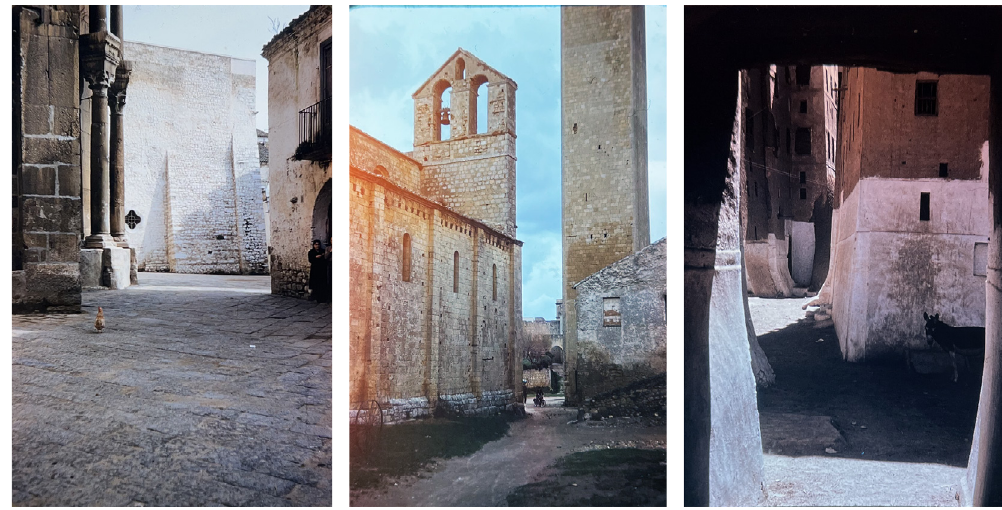
Fig. 6 Robert Venturi, Visions of urban spaces . Color slides from photographs taken by Robert